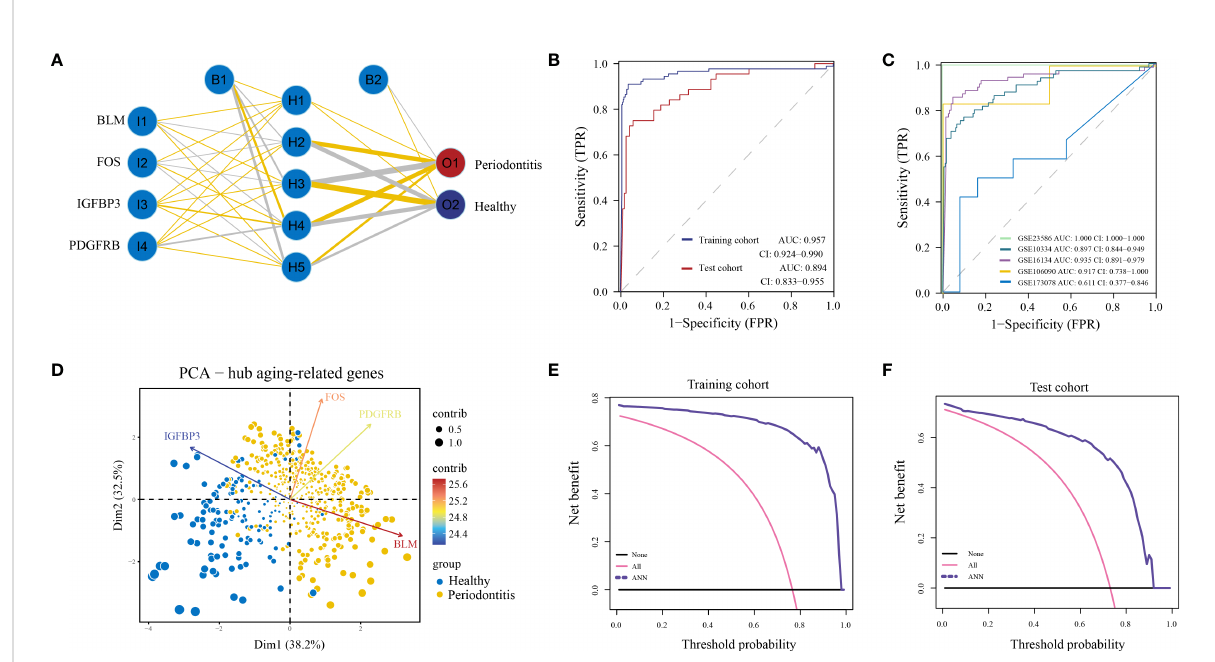
FIGURE 4 Construction of arti fi cial neural network (ANN) model. (A) ANN model has four inputs, fi ve hidden neurons, and two outputs. In this case, the 4 inputs represent the category values of the four hub ARGs. (B) The ROC curve of the ANN model in the training cohort and test cohort. (C) The ROC curve of the ANN model in validation cohorts including GSE16134, GSE10334, GSE106090, GSE173078, and GSE23586. (D) Principal component analysis (PCA) of four hub ARGs between healthy and periodontitis, the contribution of each gene is represented by a colorful arrow. DCA results to evaluate the clinical value of the ANN model via training cohort (E) and test cohort (F)